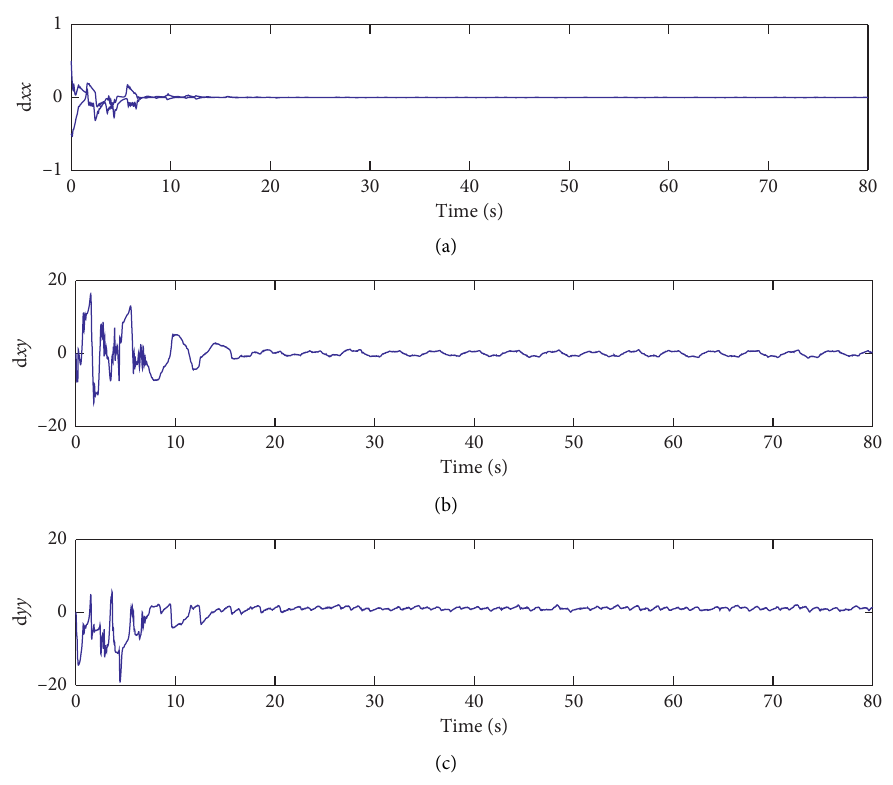
Figure 12: Adaptation of damping coefficients using conventional fast